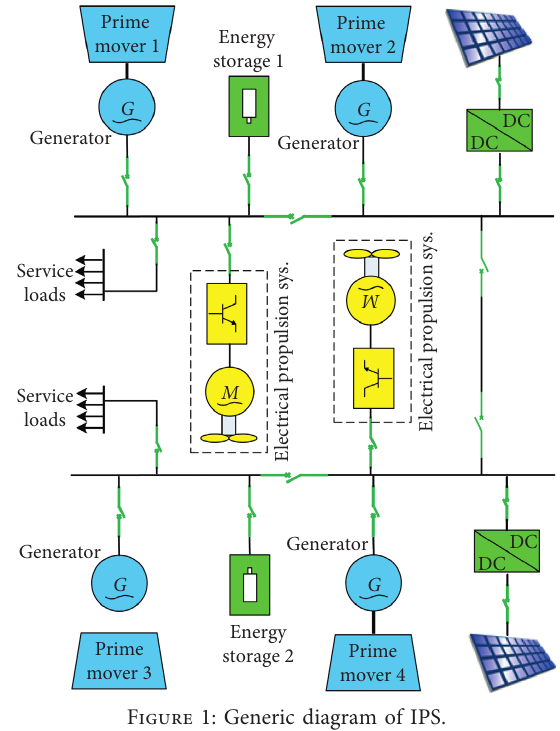
Figure 1: Generic diagram of